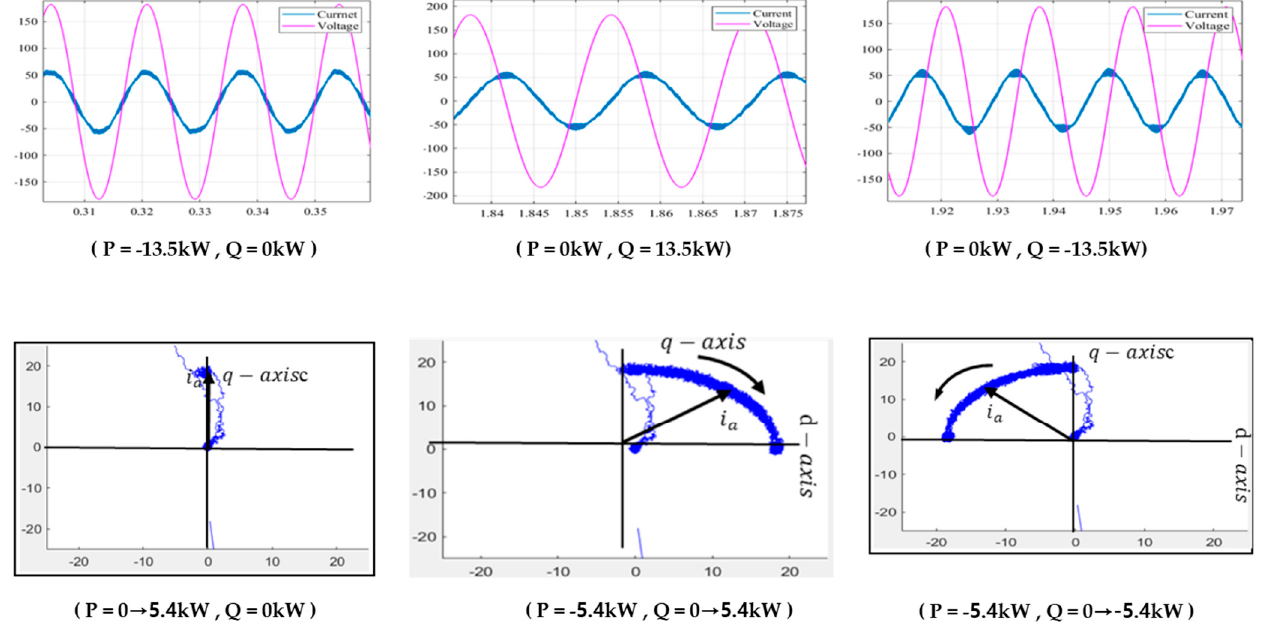
Figure 16. Results of active and reactive power control of grid-connected devices.